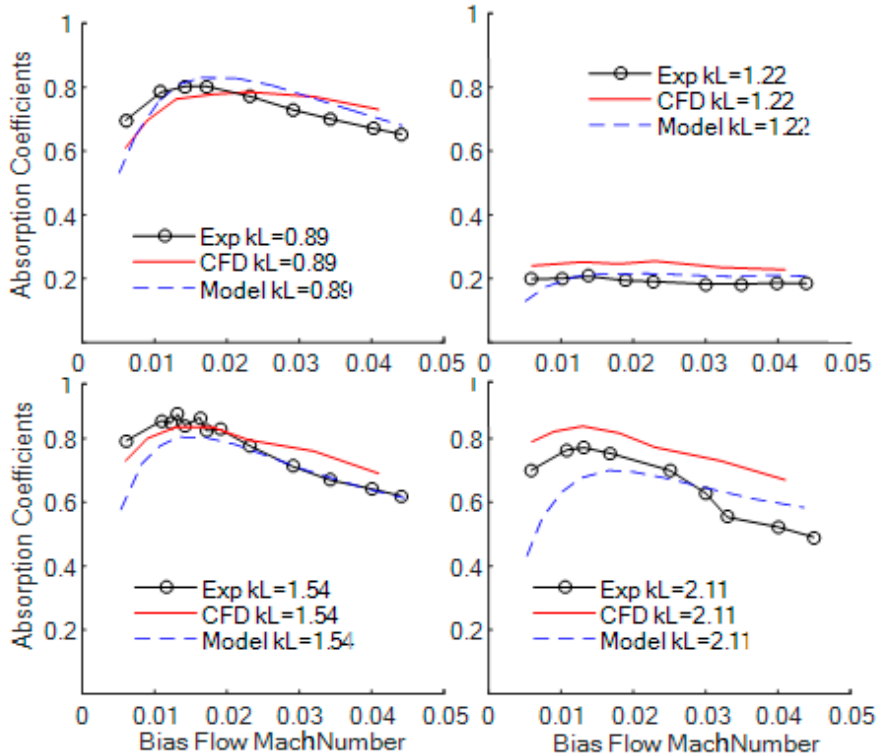
Figure 9. Numerical and experimental comparison of absorption coefficients variation with the bias flow speed in zero grazing flow conditions [21].